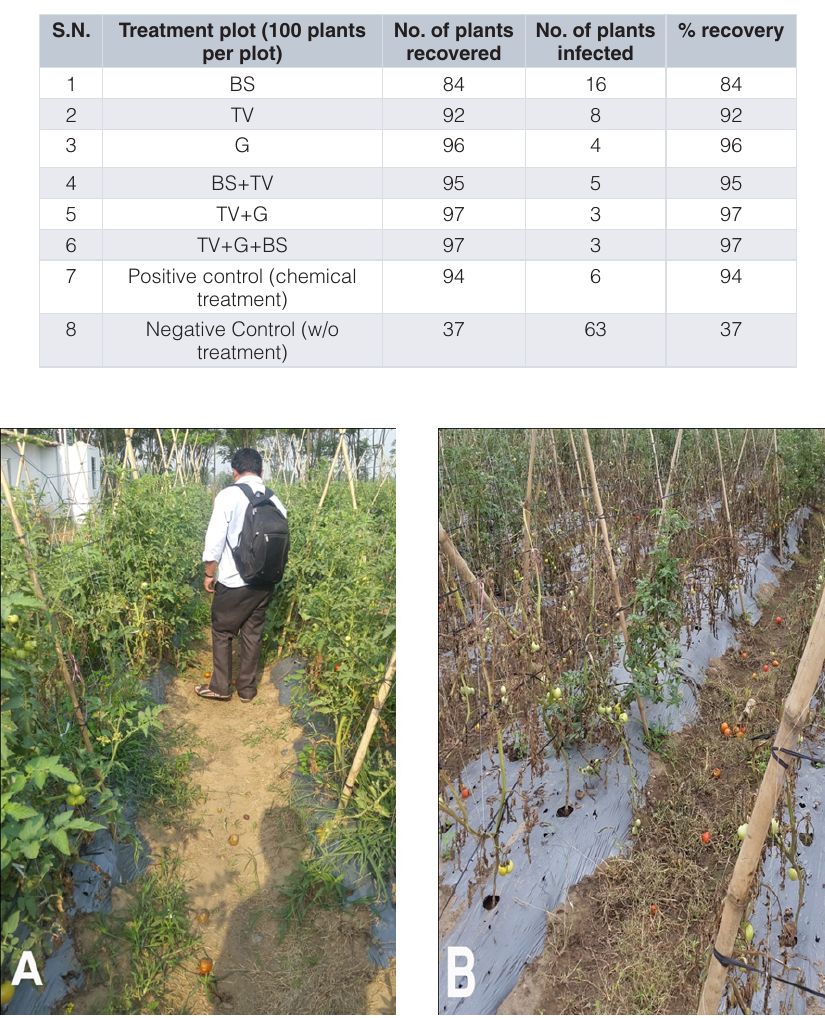
Figure 5. Differences in the field between treated and untreated plots. Field images clearly reveal that the treatment with biocontrol agents has helped to eliminate the bacterial wilt disease in the field after 8 weeks of application. ( A ) shows the growth and vigor of plants treated with biocontrol agents; ( B ) shows growth and severity of infection occurred in the untreated